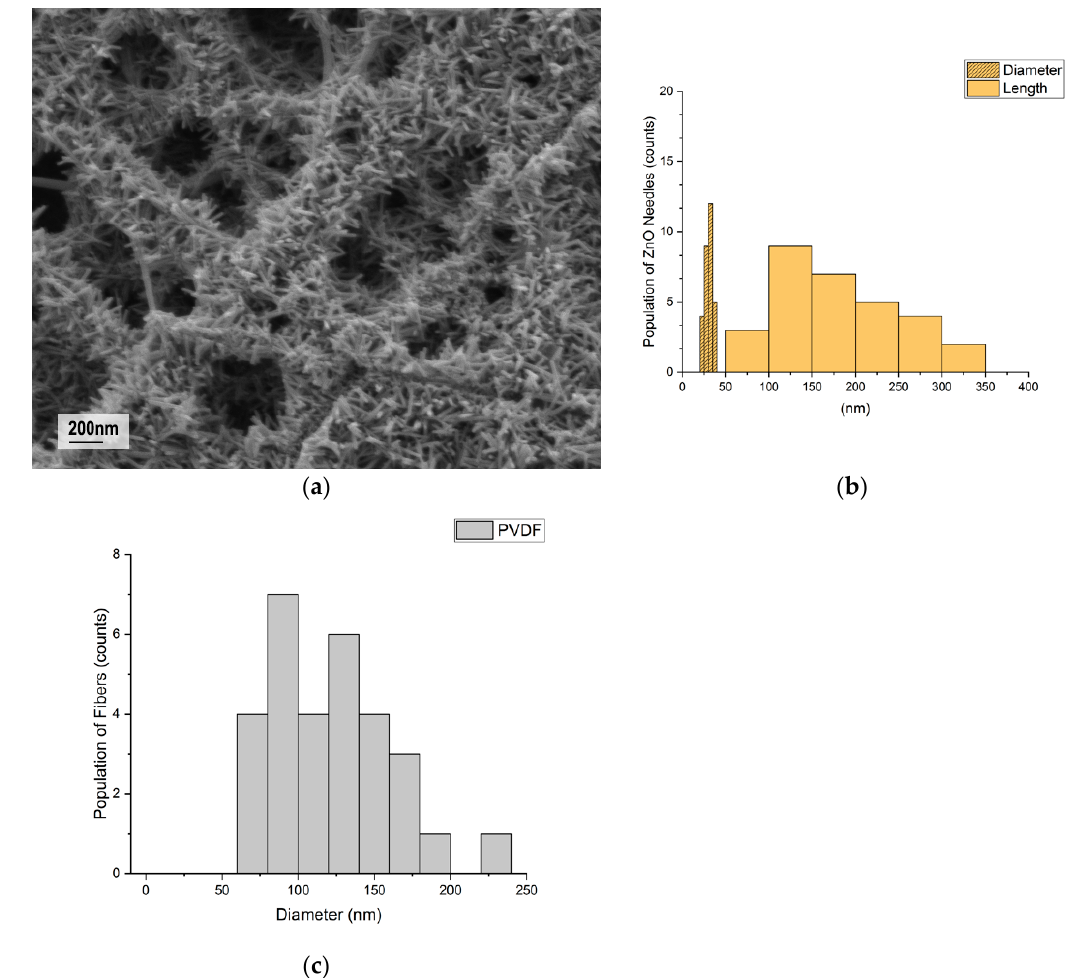
Figure 1. ( a ) An FESEM image of the ZnO nanorods grown on the surface of the electrospun PVDF nanofiber; ( b ) histogram of the length and diameter distributions of ZnO nanorods; ( c ) histogram of the diameter distribution of electrospun PVDF